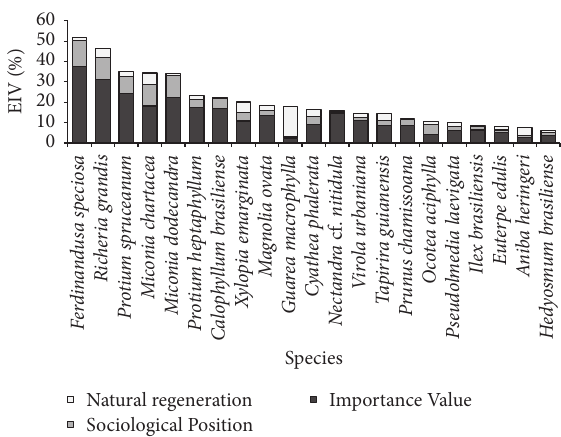
Figure 3: Expanded Importance Value (EIV) of the 21 most impor- tant species found in Riacho Fundo swamp gallery forest, Central Brazil. This index takes into account the Importance Value (IV), the Sociological Position (SP), and the natural regeneration (NR) of the